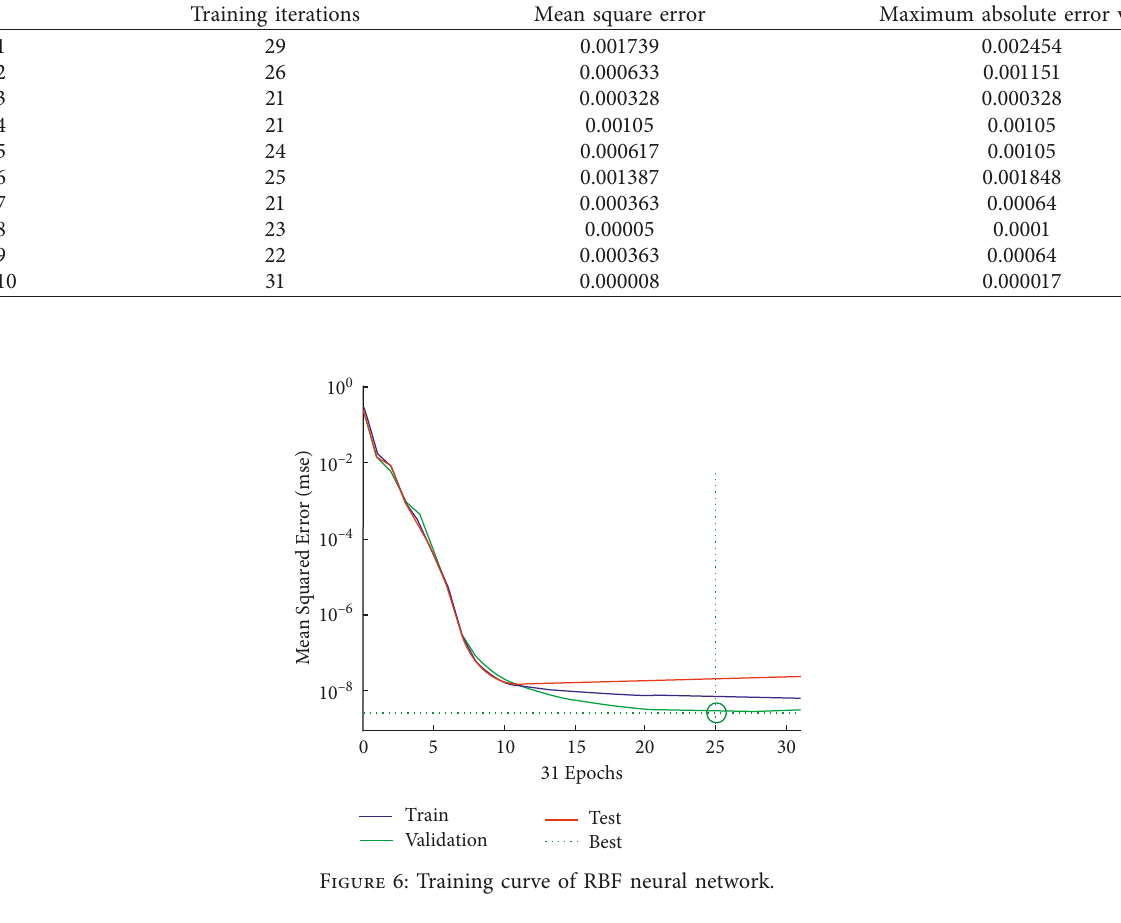
Table 4: Summary of the results of the reliability prediction model.